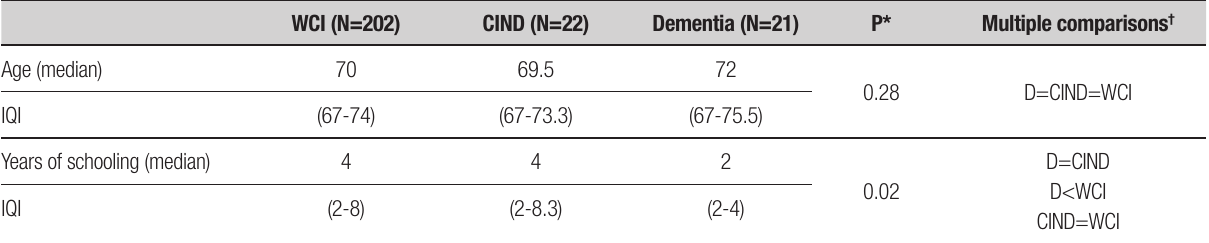
Table 1. Demographic data of patients with dementia, cognitively impaired not demented (CIND) and individuals without cognitive impairment (WCI). WCI (N=202)